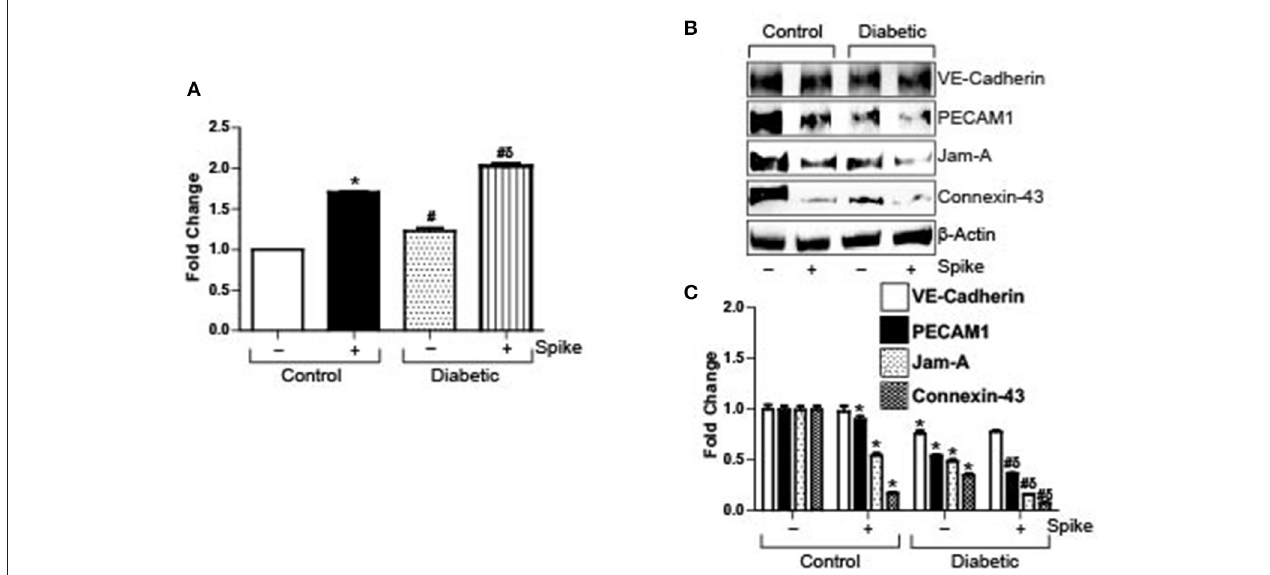
FIGURE 1 | SARS-CoV-2 spike protein (Spike) increases endothelial permeability by downregulation of junctional proteins in diabetic endothelial cells. (A) Endothelial transwell permeability assay, mean data expressed as fold change. n = 6 for each, * P < 0.05 vs. untreated control, δ P < 0.05 vs. untreated diabetic, # P < 0.05 vs. Spike-treated control. (B) Representative Western blot indicating expression of endothelial junctional proteins in endothelial cell culture with or without Spike treatment. (C) Mean data indicating fold change in protein expression. n = 6 for each, * P < 0.05 vs. untreated control, δ P < 0.05 vs. untreated diabetic, # P < 0.05 vs. Spike-treated